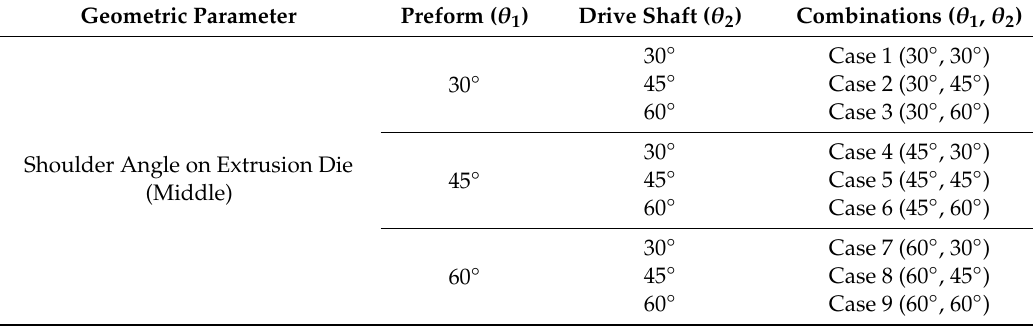
Figure 6. Numerical simulation models for the preform forging and combined extrusion: ( a ) FE model for the forward extrusion model; ( b ) FE model for the combined extrusion. Table 2. Available combinations of the geometric parameters for the preform and drive shaft.